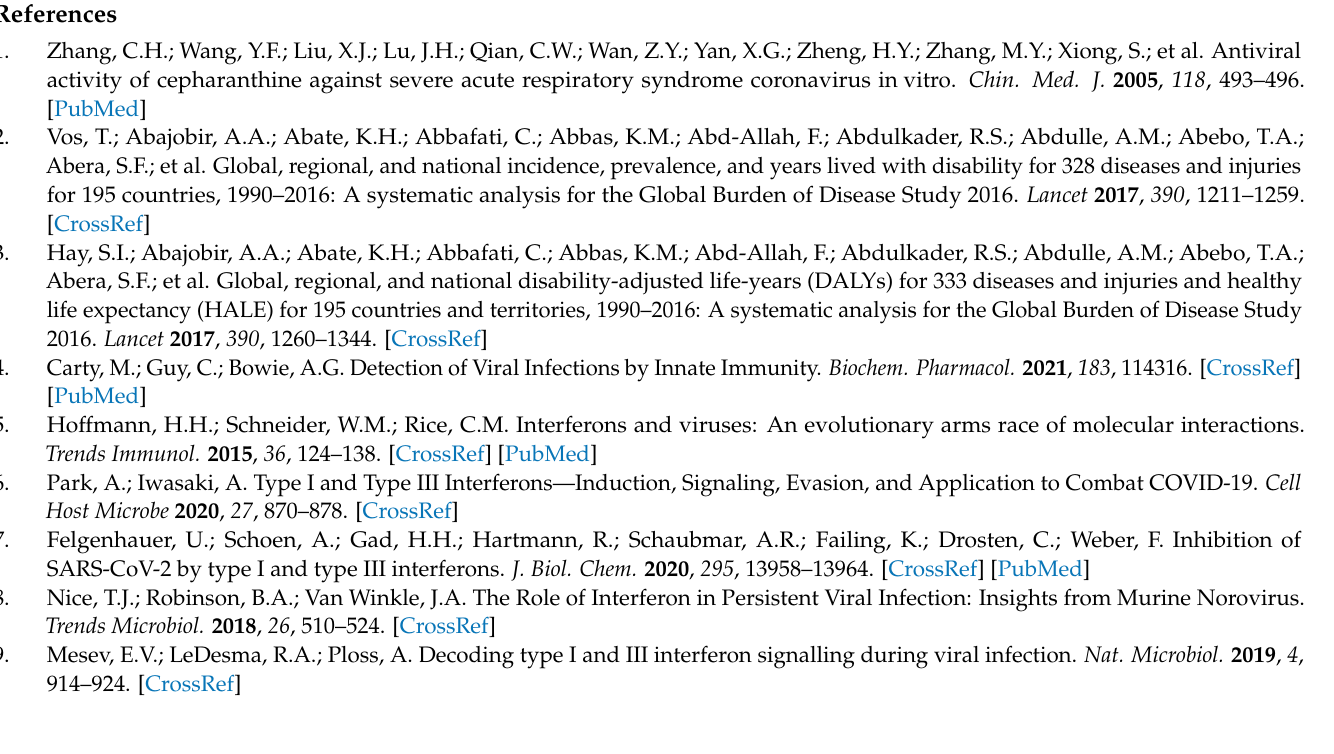
Calu-3 cells, Figure S6: Effect of IFNa2a-remdesivir on transcription of host genes in human lung organoids (LOs), Figure S7: Effect of IFNa2a-remdesivir on metabolism in human lung organoids (LOs), Figure S8: Combinations of IFNa2a with sofosbuvir or telaprevir reduce HCV-mediated GFP expression in Huh-7.5 cells, Figure S9: Combinations of IFNa2a with ribavirin or NITD008 reduce HEV-mediated GFP expression in Huh-7.5 cells, Figure S10: Combination of pimodivir-IFNa2a reduces FluAV infection in A549 cells, Figure S11: Combination of lamivudine-IFNa2a reduces HIV-1 virus infections in TZM-bl